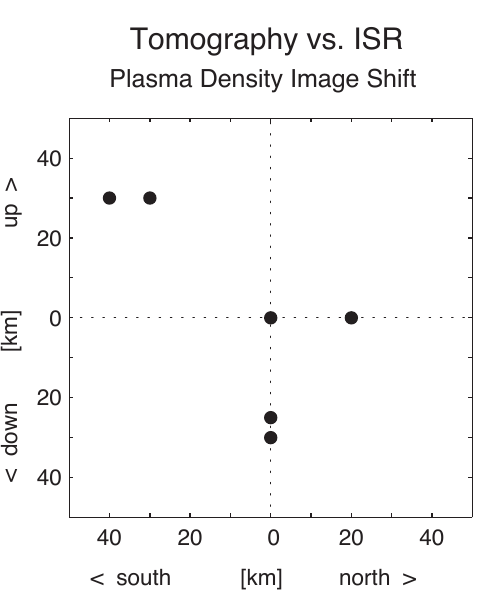
Fig. 7. Horizontal and vertical shifts applied to the six tomographic images which agreed well or partially with Sondrestrom ISR observations, in order to achieve best agreement with the ISR plasma density